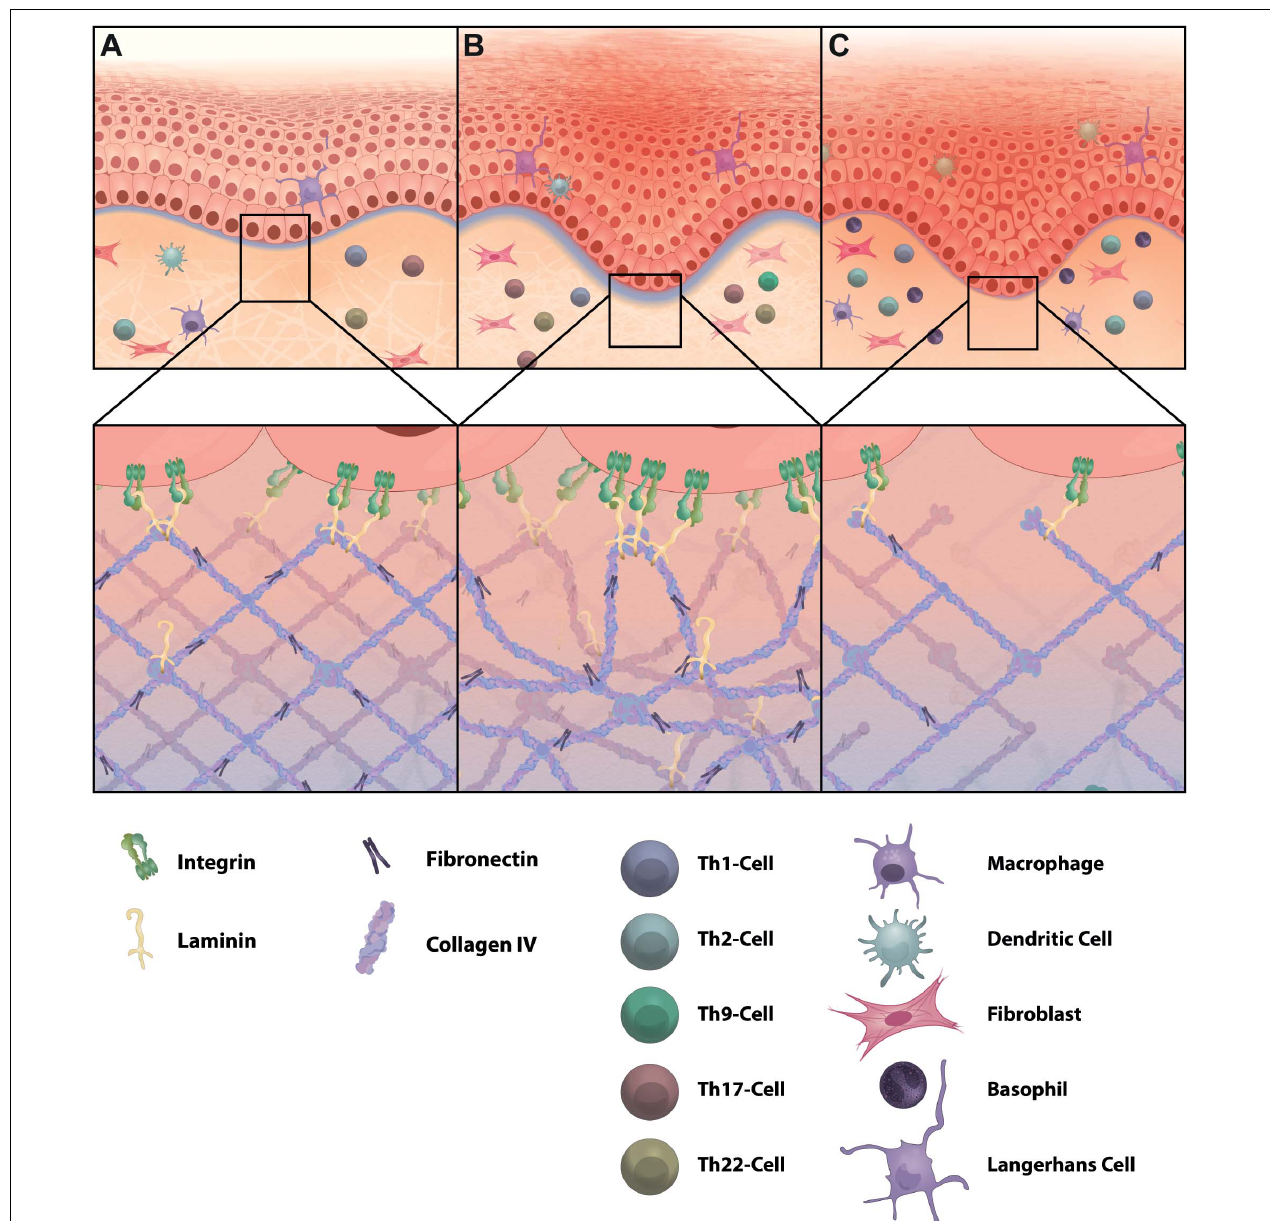
FIGURE 5 | ECM changes in skin inflammation. Inflammatory skin diseases can alter the composition and structure of the ECM. (A) In healthy skin collagen type IV builds a network with interspersed laminin to form the BM. This provides attachment points for basal keratinocytes of the epidermis and forms a protective layer to control leukocyte navigation through adjusted gap sizes and limits entry of harmful invaders via incorporation of sticky PG/GAGs. (B) Psoriasis is defined by high infiltration of IL-17 and IL-22 producing T helper cells. The BM in psoriasis is highly unstructured and thicker compared to healthy skin and shows elevated levels of laminin and fibronectin. (C) In atopic dermatitis, which is a T helper 2-driven inflammatory skin disease, collagen type IV and fibronectin are decreased, resulting in a thinner BM. Increased hyaluronan and MMPs are further characteristic for atopic dermatitis (not illustrated here). Not all relevant immune cells are